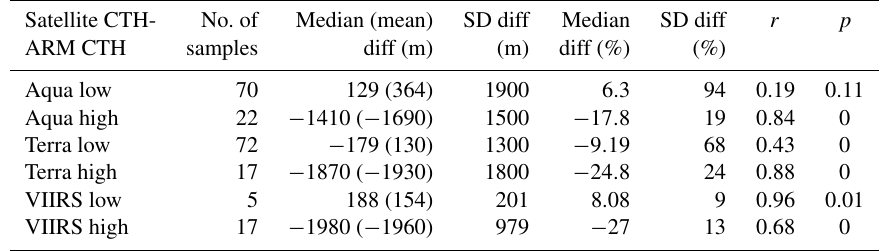
Table 4. Same as in Table 3 except for daytime